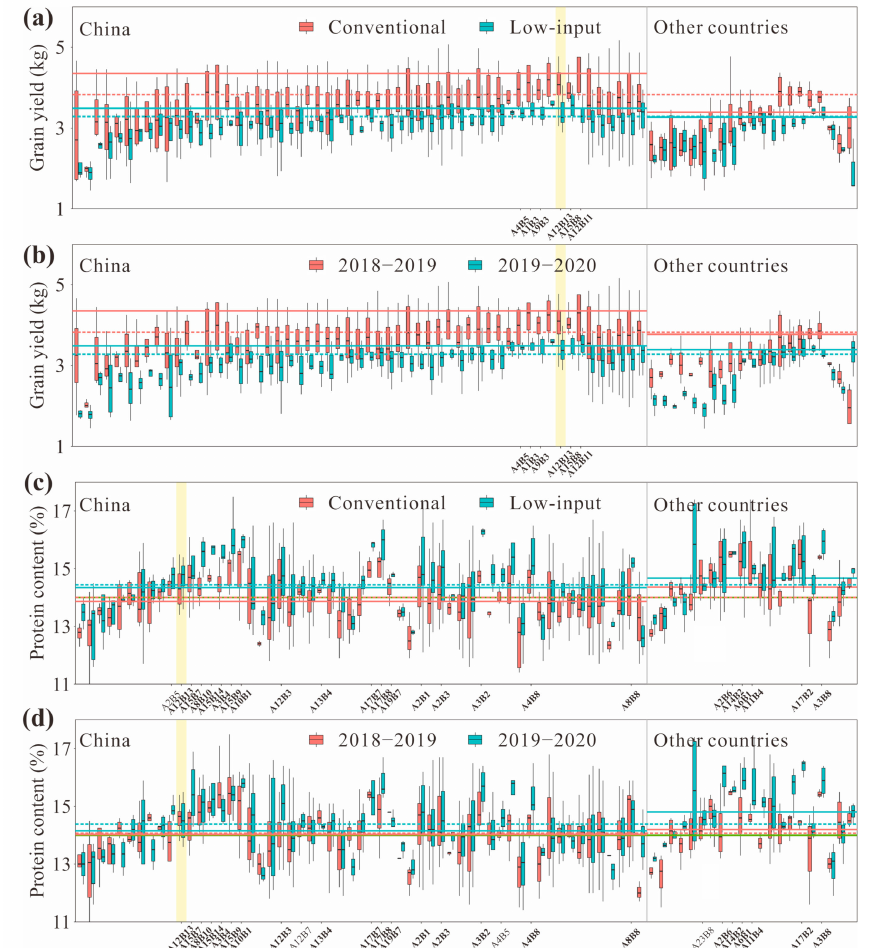
Figure 5. Illustration of the concepts for the simultaneous selection of grain yield (GY) ( a , b ) and protein content (PC) ( c , d ) in wheat under different management treatments and growing seasons. In ( a , b ), the red dotted line is the dividing line of the top 15.87% of the tested materials with the highest GY of varieties from China or other countries under conventional management or in the 2018–2019 growing season, while the blue dotted line is the dividing line of the top 15.87% of the tested materials with the highest GY of varieties from China or other countries under low-input management or in the 2019–2020 growing season; the solid red line is the dividing line of the top 15.87% of the tested materials with the highest GY under conventional management or in the 2018–2019 growing season, while the solid blue line is the dividing line of the top 15.87% of the tested materials with the highest GY under low-input management or in the 2019–2020 growing season. In ( c , d ), the red dotted line is the mean of PC of varieties from China or other countries under conventional management or in the 2018–2019 growing season, while the blue dotted line is the mean of PC of varieties from China or other countries under low-input management or in the 2019–2020 growing season; the solid red line is the mean of PC of all tested materials under conventional management or in the 2018–2019 growing season, while the solid blue line is the mean of PC of all tested materials under low-input management or in the 2019–2020 growing season. The solid green line is the Chinese good quality strong-gluten wheat standard (14%). For orientation, the allelic combinations that fell among the top 15.87% of the tested materials with the highest GY or PC levels higher than the mean of all test materials in each environment are labeled. The allelic combinations with either such high GY or high PC levels in every environment are bolded, but the genotypic combination that fulfil both assumptions is highlighted in the yellow vertical